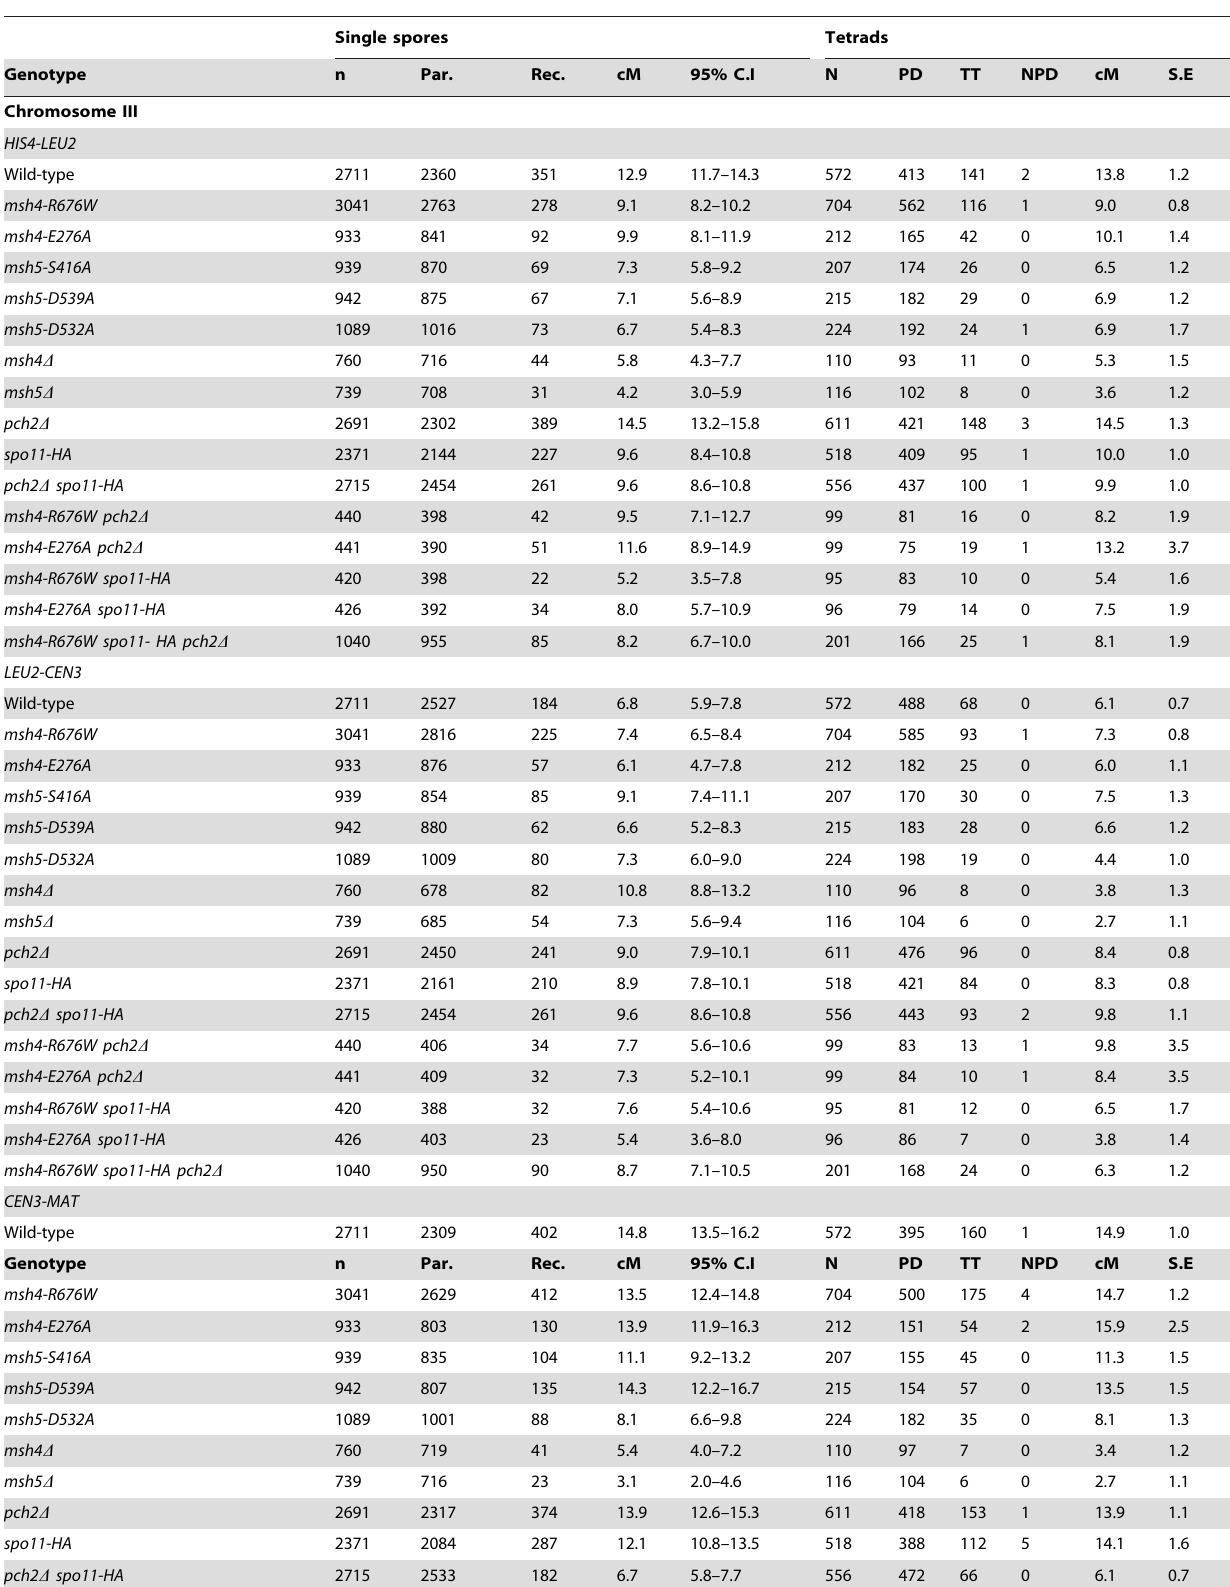
Table 2. Genetic map distances and distribution of parental and recombinant progeny in msh4 , msh5 mutants in the NHY942/ NHY943 strain